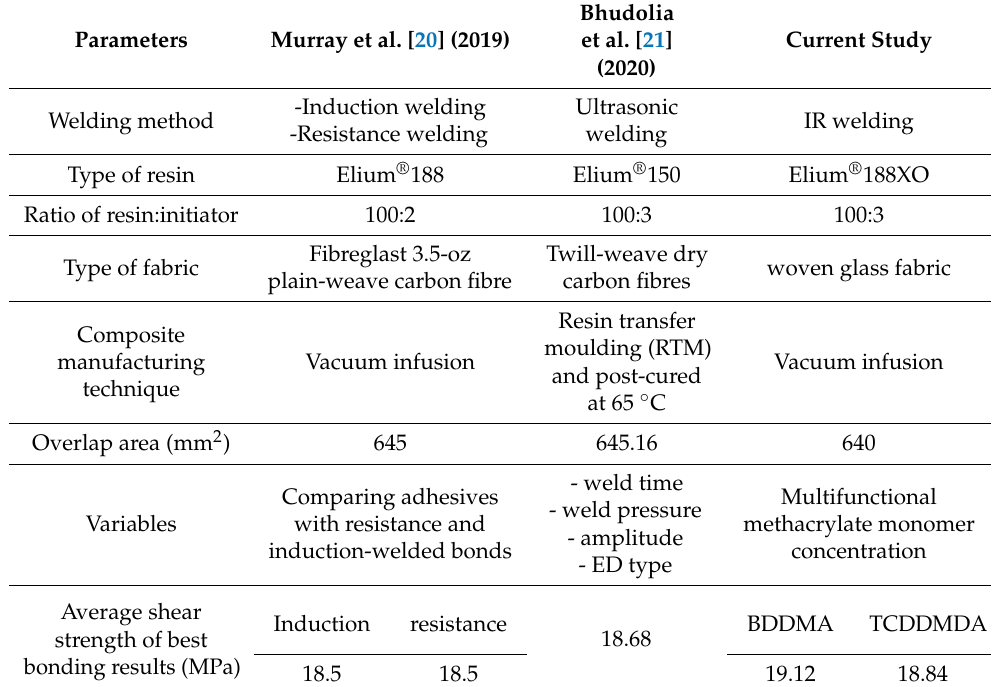
Table 5. SLS results of IR welding versus induction, resistance, and ultrasonic welding.